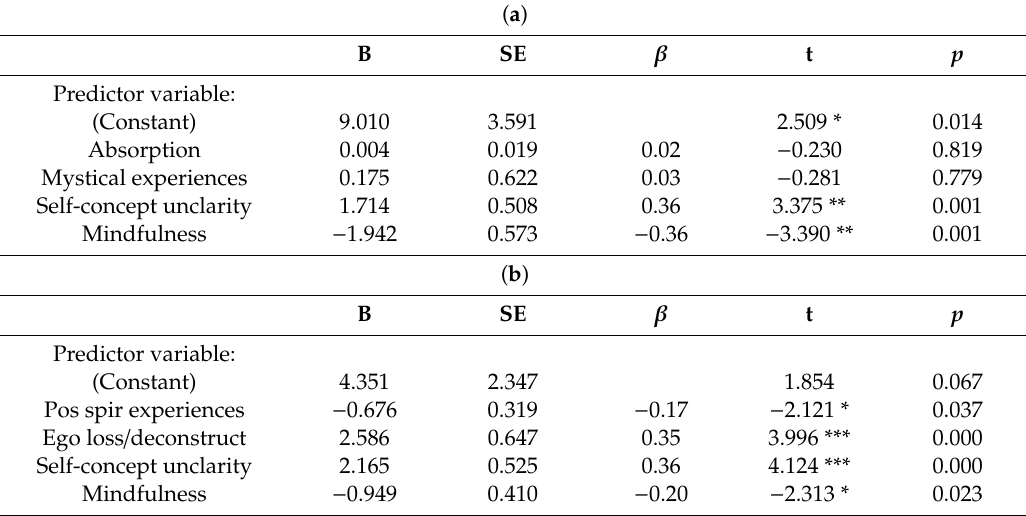
Table 2. ( a ) Regression Analysis (Enter Method) predicting Anxiety (n = 82, subsample 1). ( b ) Regression Analysis (Enter Method) predicting Anxiety (n = 89, subsample